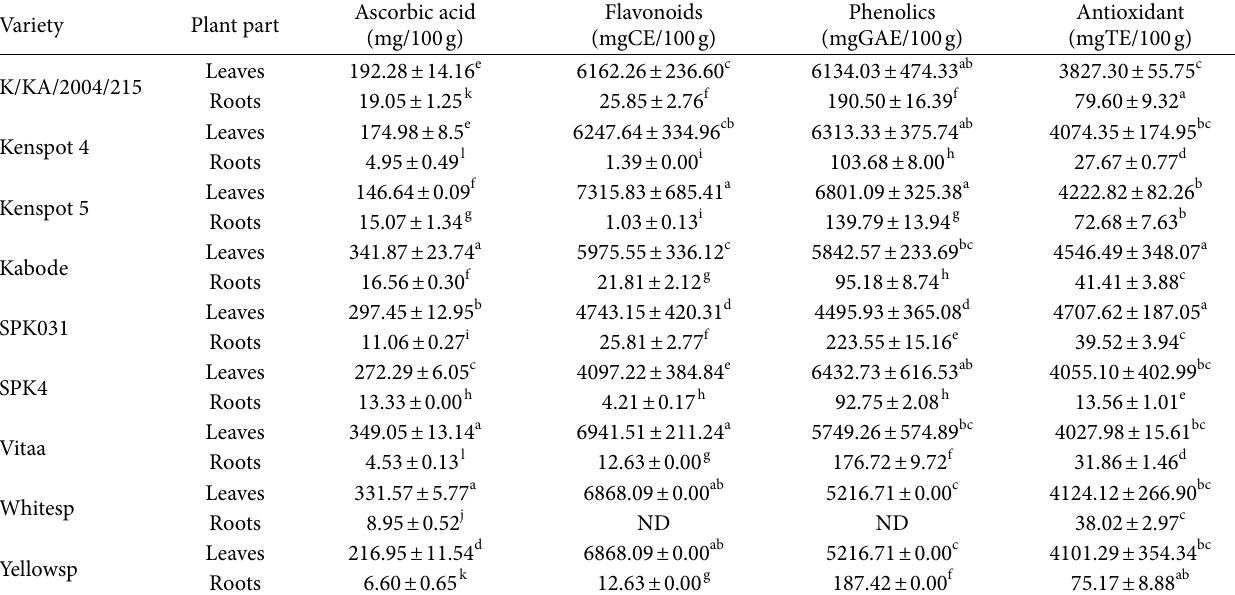
Table 3: Ascorbic acid, flavonoid, phenolic and antioxidant contents (in dry weight basis) in leaves and roots of nine Kenyan sweet potato